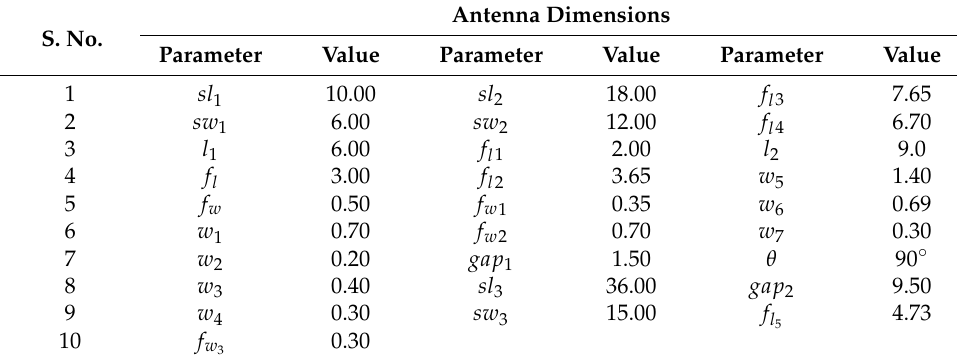
Figure 2. Design flow of the array antenna for wireless terminals. Units: mm. Table 1. Various dimensions of the proposed array antenna.